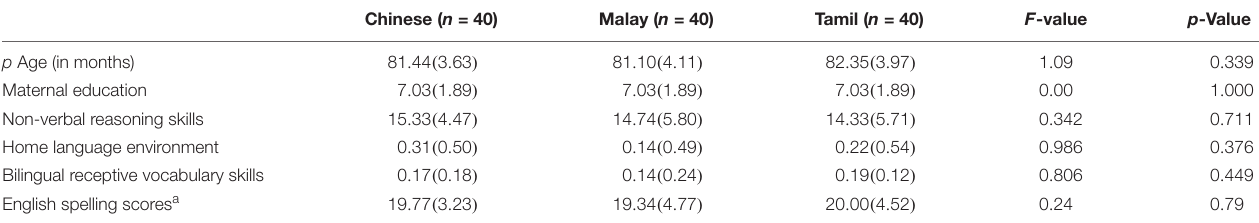
TABLE 2 | Subsample’s background information across three Asian language groups ( N =